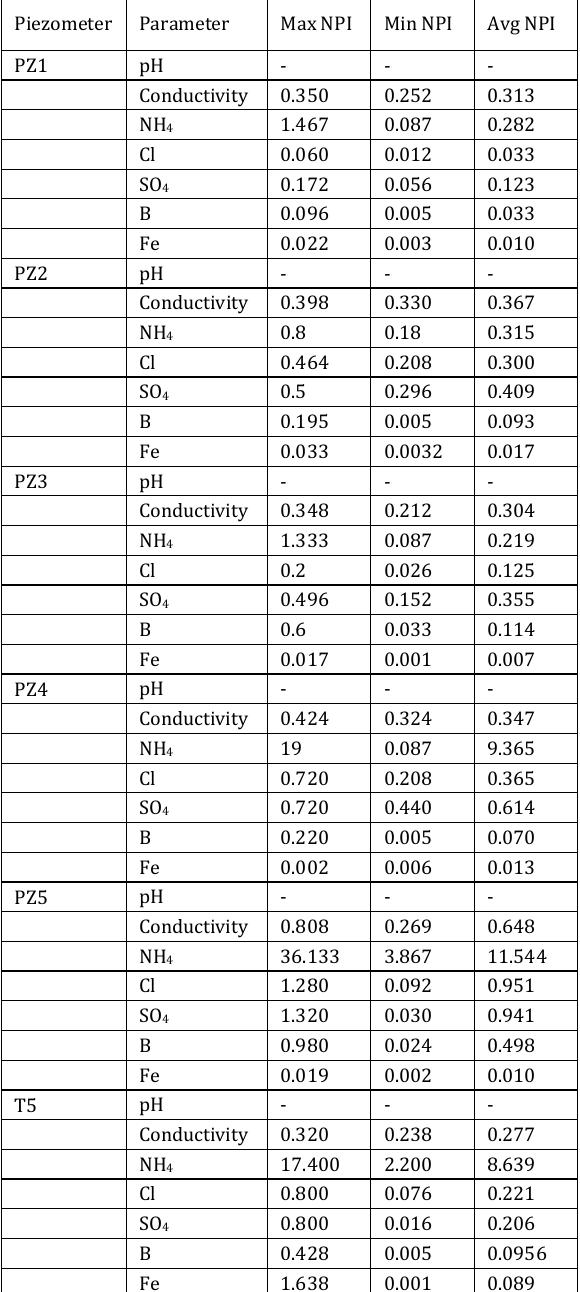
Table 1. Nemerow Pollution Index